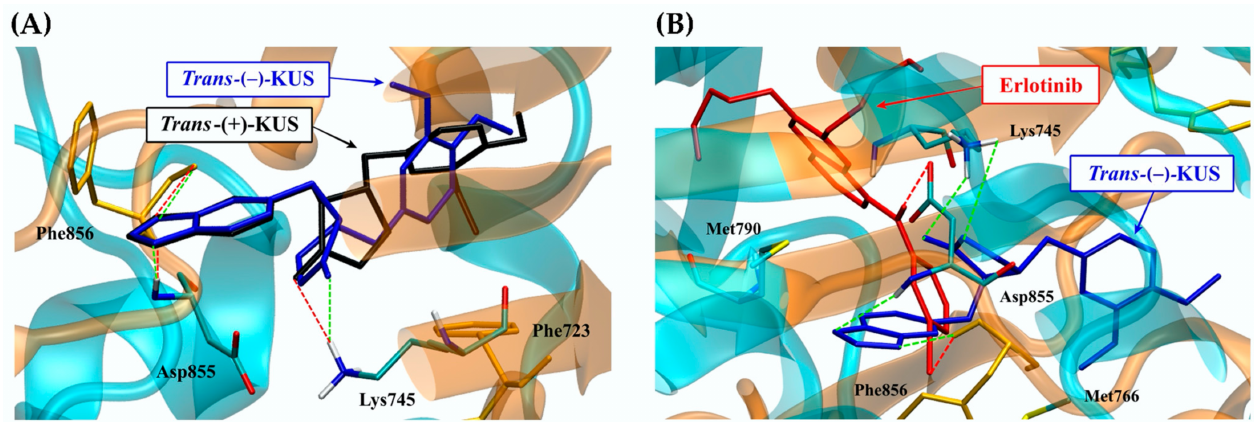
Figure 7. EGFR binding pocket alignment: ( A ) trans -( − )-kusunokinin (blue) compared to trans -(+)-kusunokinin (black); ( B ) trans -( − )-kusunokinin (blue) compared to erlotinib (red). Lys745, Asp855 and Phe856 were responsible for hydrogen bonding between trans -( − )-kusunokinin and EGFR (green dash line). The red dash line represented hydrogen bonding of trans -(+)-kusunokinin or the known inhibitor. Docking poses of the ligands and amino acids interacting with the ligands through hydrophobic interaction or π -sulfur were shown as sticks.